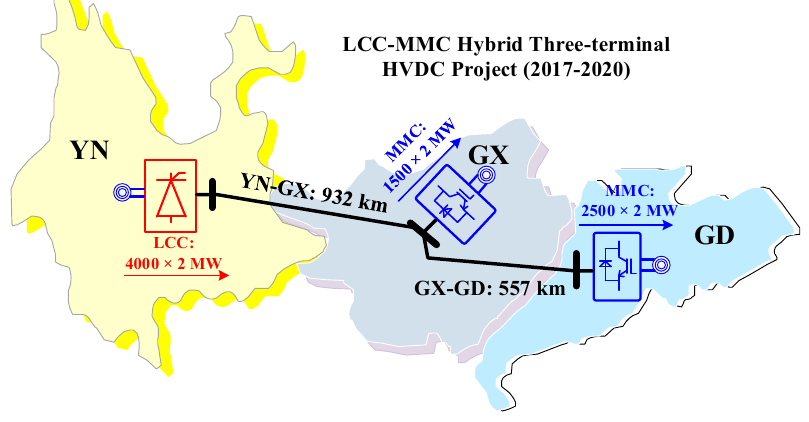
Figure 1. The first multi-terminal LCC-MMC hybrid HVDC project in China.